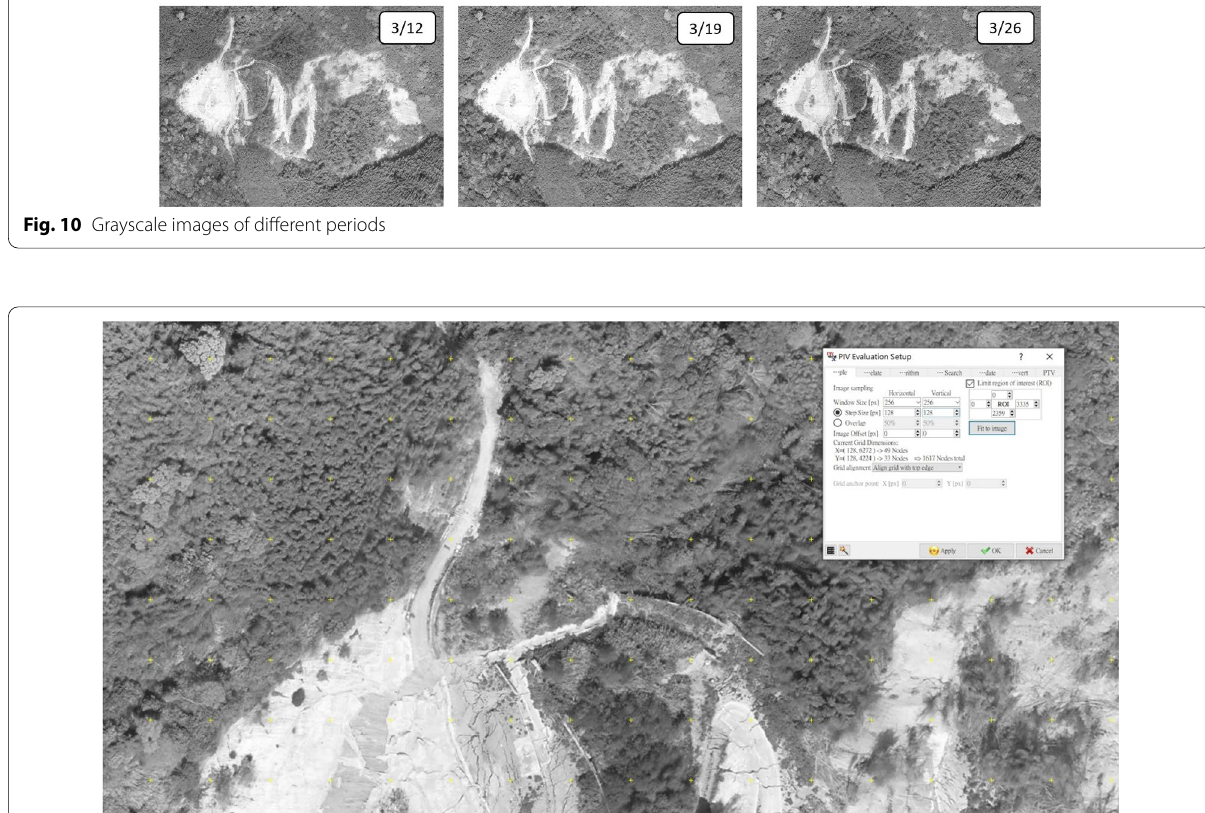
Fig. 11 PIV evaluation setup in the study